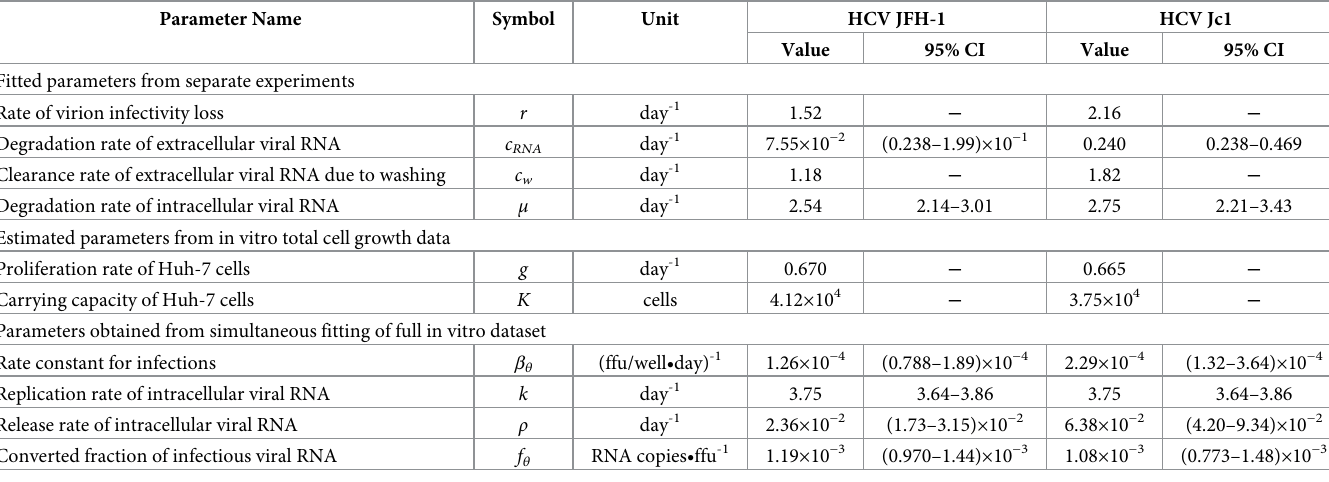
Table 1. Parameter values estimated from the cell culture infection